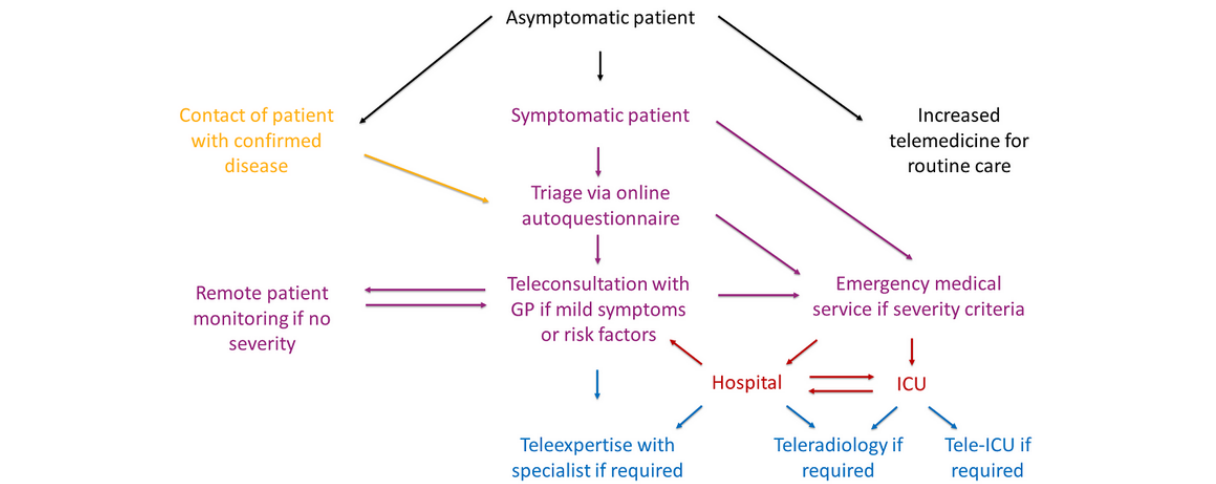
Figure 1. Conceptual framework of telemedicine for the coronavirus disease 2019 (COVID-19) pandemic. GP: general practitioner; ICU: intensive care